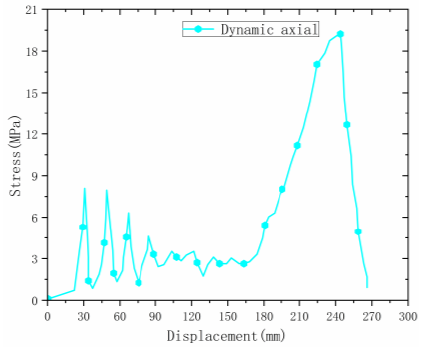
Figure 11. Dynamic test in the axial direction.